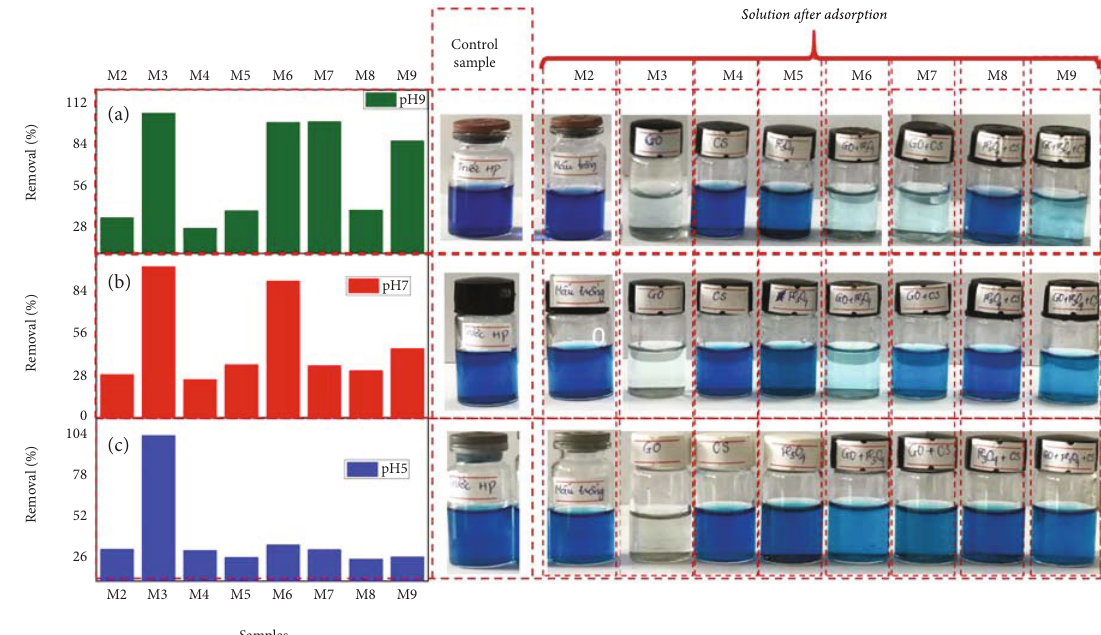
Figure 3: E ff ects of pH on MB adsorption onto the GFC/NWPF absorbent: (a) pH 5, (b) pH 7, and (c) pH 9 (inserted images: corresponding color of MB solutions before and after the adsorption